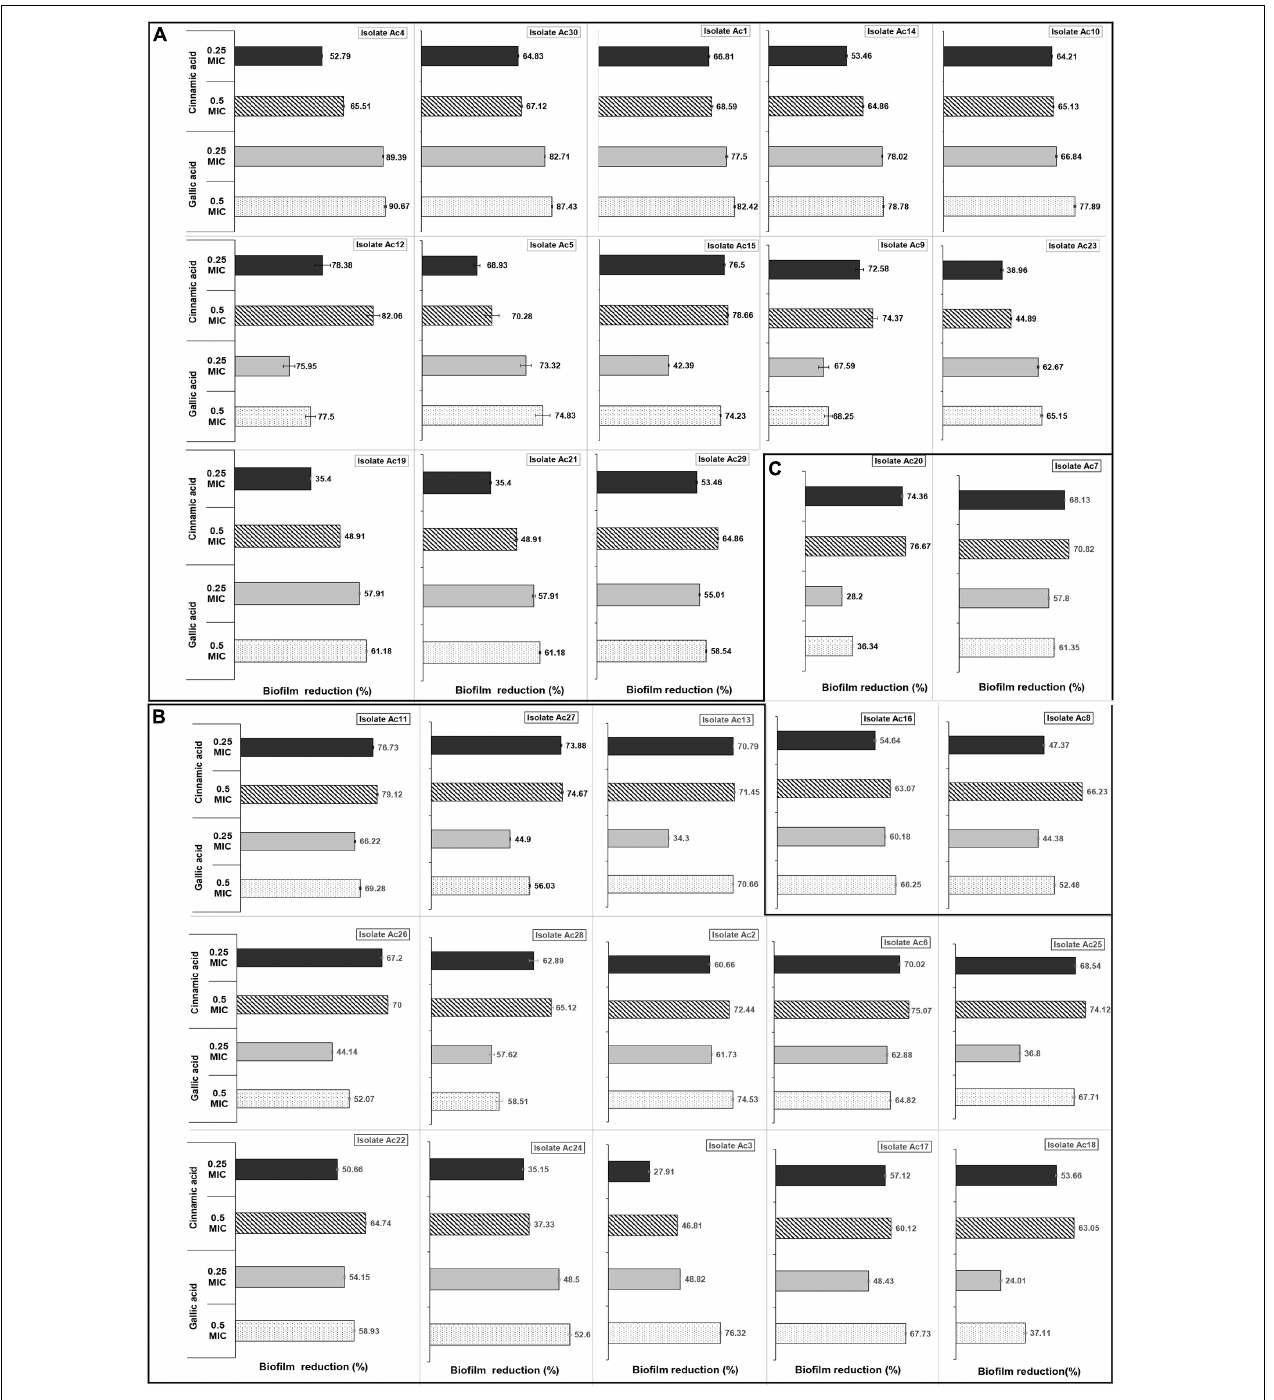
FIGURE 6 | Inhibitory effect of cinnamic and gallic acids on biofilm formation of each of the 30 MDR A. baumannii isolates. Clustered bar charts demonstrate biofilm reduction (%) following treatment with subinhibitory concentrations of cinnamic acid 1/2 MICs (stripped bars), 1/4 MICs (black bars), and gallic acid 1/2 MICs (dotted bars), and 1/4 MICs (gray bars) on (A) strong, (B) moderate, and (C) weak biofilm